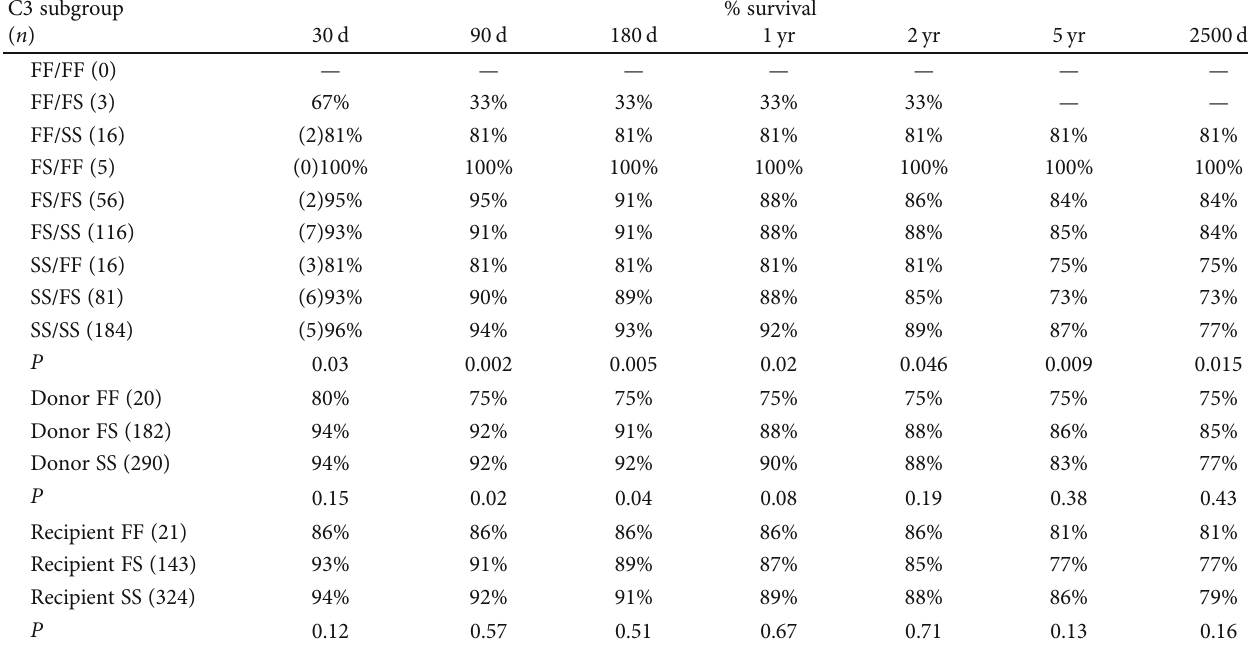
Table 4: Life tables for graft survival. Graft survival life table up to 2500 days posttransplantation in liver graft donors and recipients classi fi ed according to C3 genotype or presence of C3F allele.